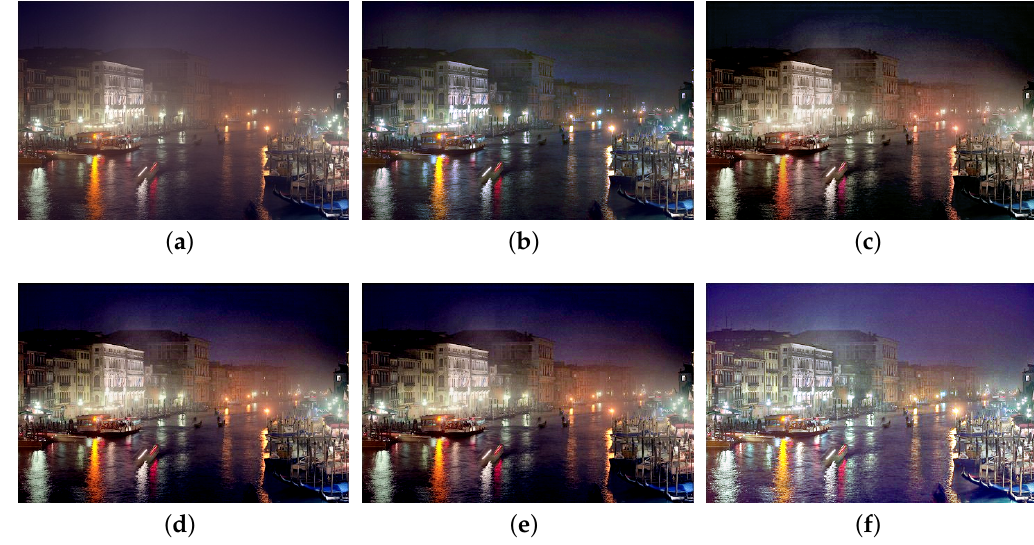
Figure 13. Comparisons with other nighttime dehazing methods on test image Riverside .